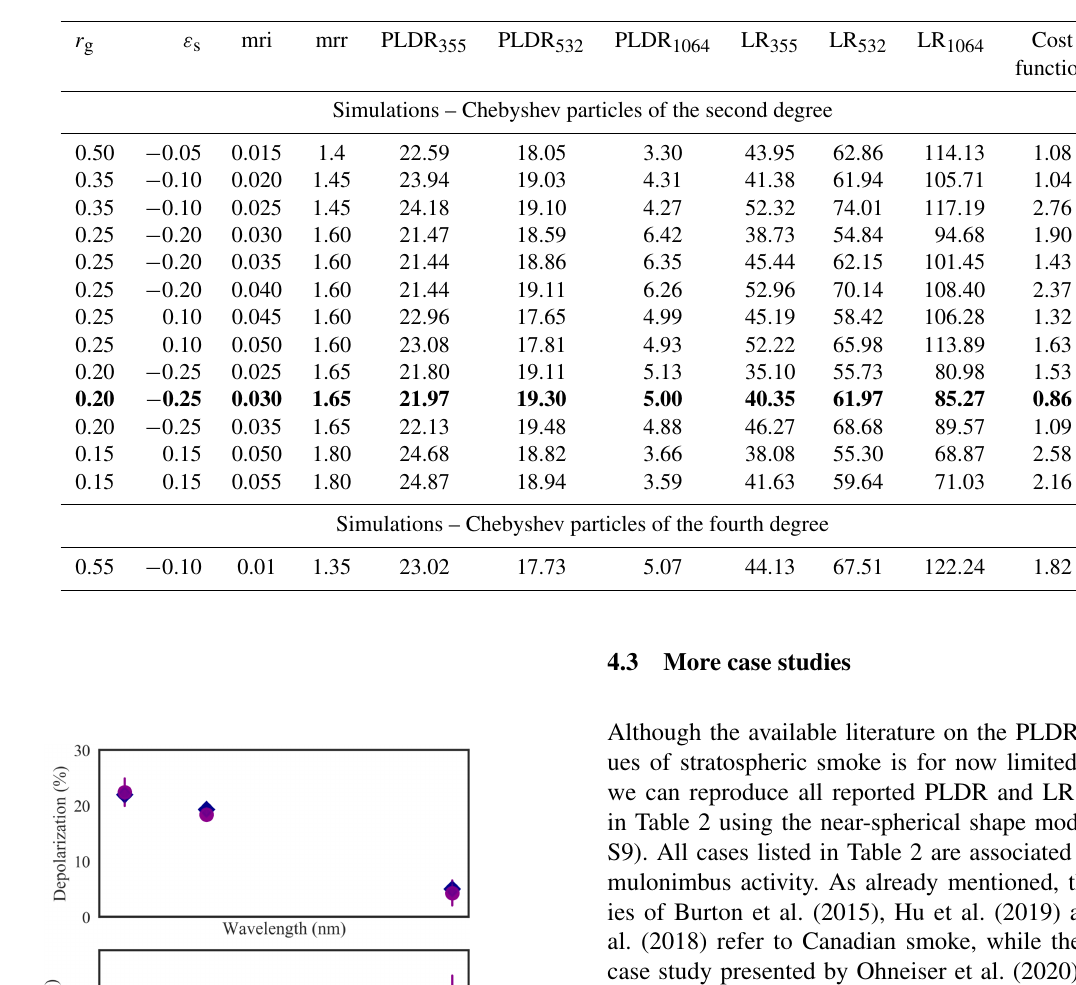
Table 4. Calculated properties of Chebyshev particles of the second ( T 2 ) and fourth ( T 4 ) degree that reproduce the PLDR and LR at 355, 532 and 1064nm, as reported in Haarig et al. (2017). Also shown is the corresponding cost function of each solution. The solution that minimizes the cost function (Eq. 8) is highlighted in bold.